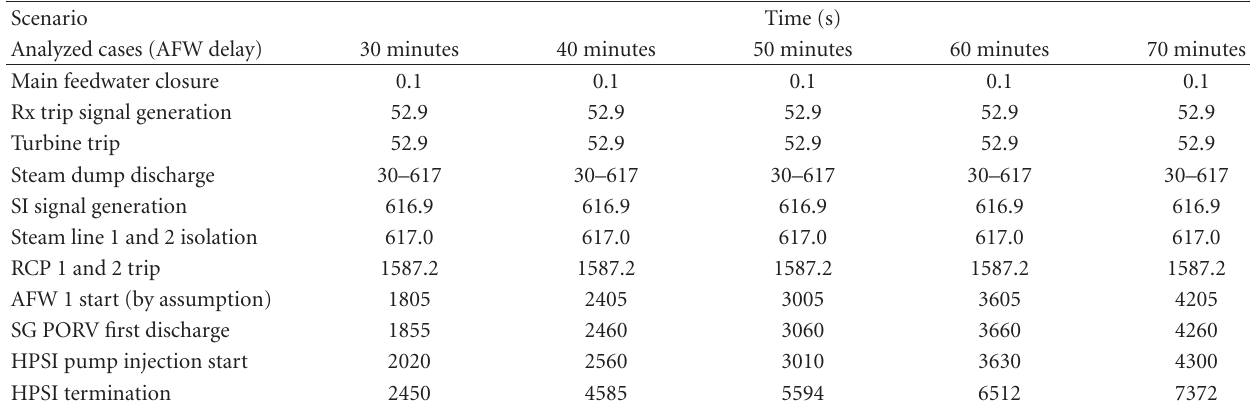
Table 4: Sequence of main events for LOFW